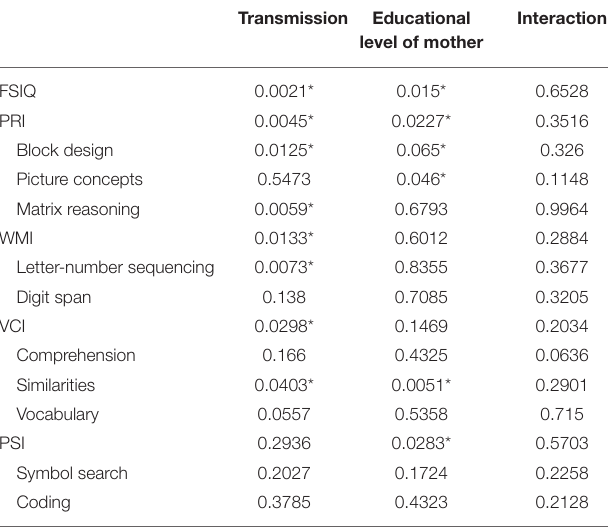
TABLE 4 | p -values for individual effects (NF1 group, level of education mother) and interaction from a 2-factor ANOVA including interaction performed on each IQ